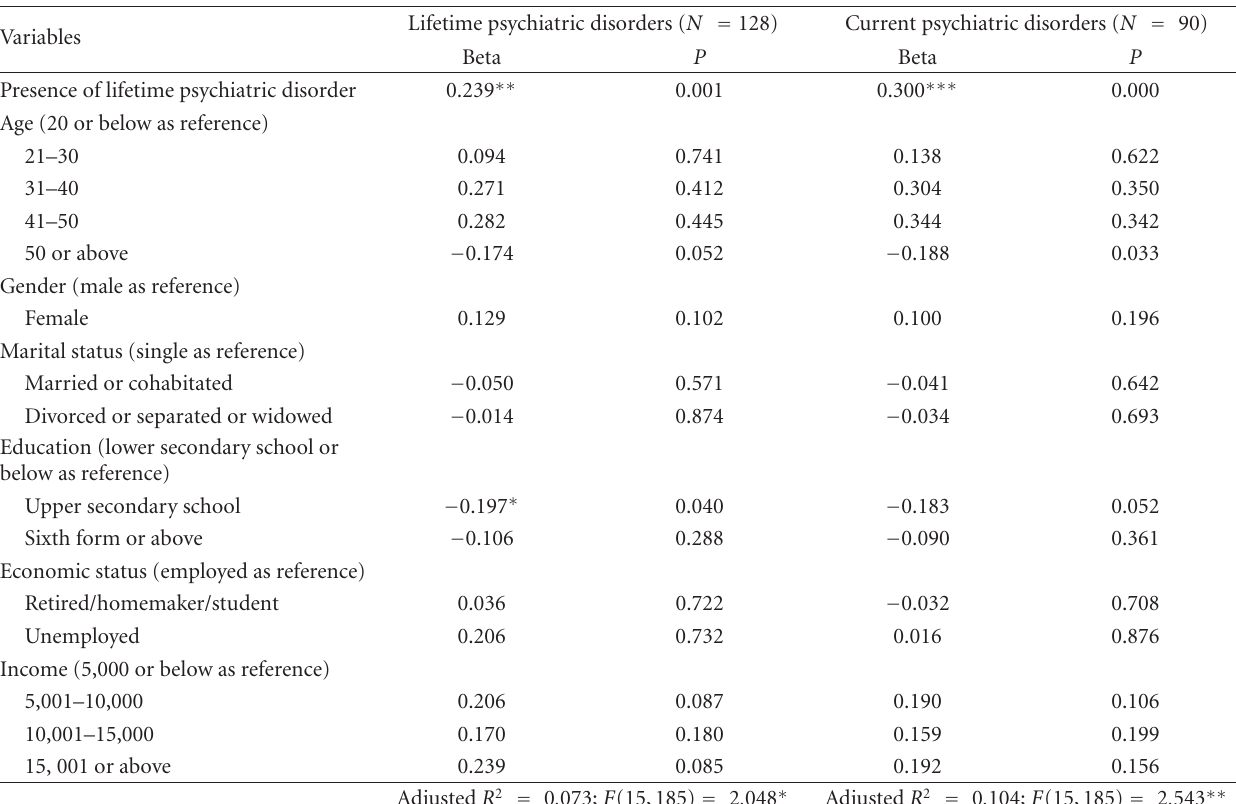
Table 5: Lifetime and current psychiatric disorder and demographic predictors of gambling